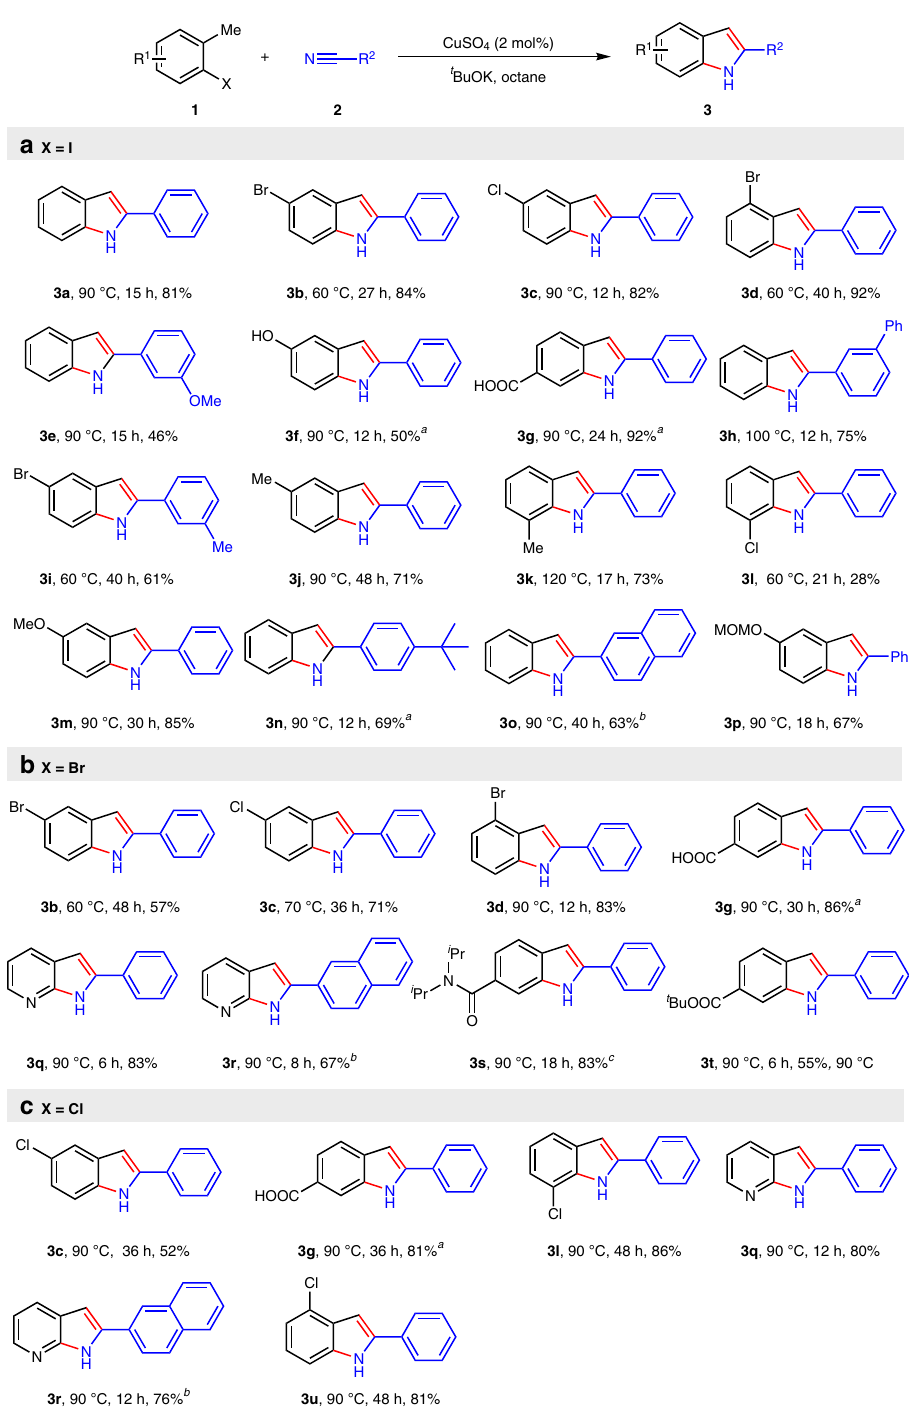
Fig. 3 Scope of methyl (het)arenes and nitriles. Reaction conditions: CuSO 4 (2 mol%), 1 (1 mmol), 2 (5 mmol), t BuOK (5 mmol), octane (0.75 mL). Extra 1 mmol t BuOK was used for 3f and 3g . a 2 (1.5 mL) was used as solvent. b Octane (3 mL). c CuSO 4 (20 mol %) was used. a 2-Iodomethyl arenes were subjected to the standard conditions. b 2-Bromomethyl arenes were subjected to the standard conditions. c 2-Chloromethyl arenes were subjected to the standard